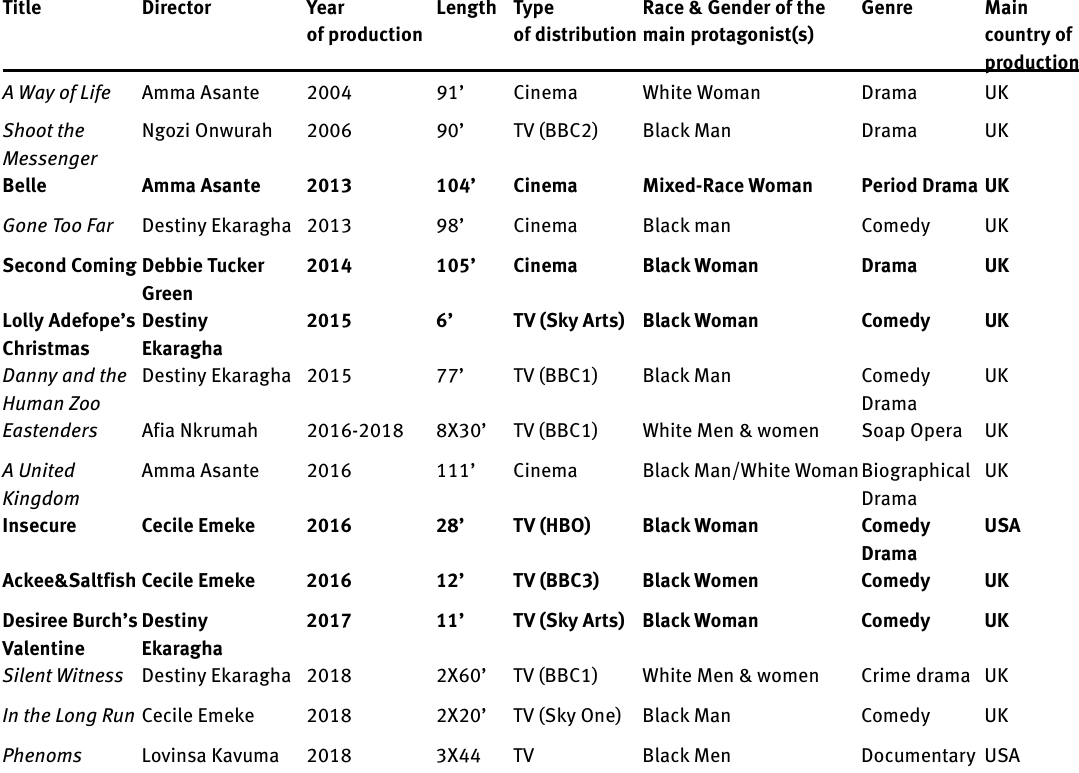
Table 1. List of mainstream films/television shows directed by Black British women since the